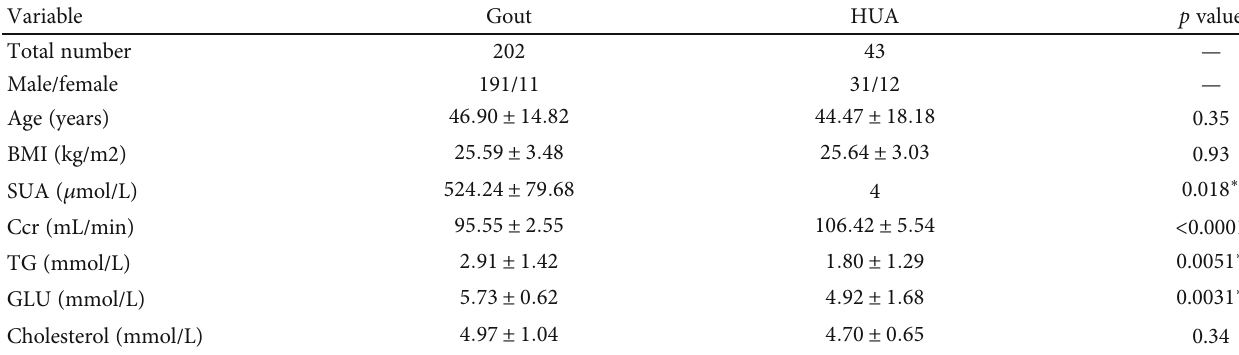
Table 1: Demographics and clinical characteristics of the study population.